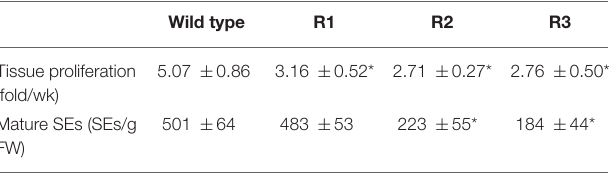
TABLE 1 | The proliferation of embryogenic tissue and maturation of SEs before and after genome editing.